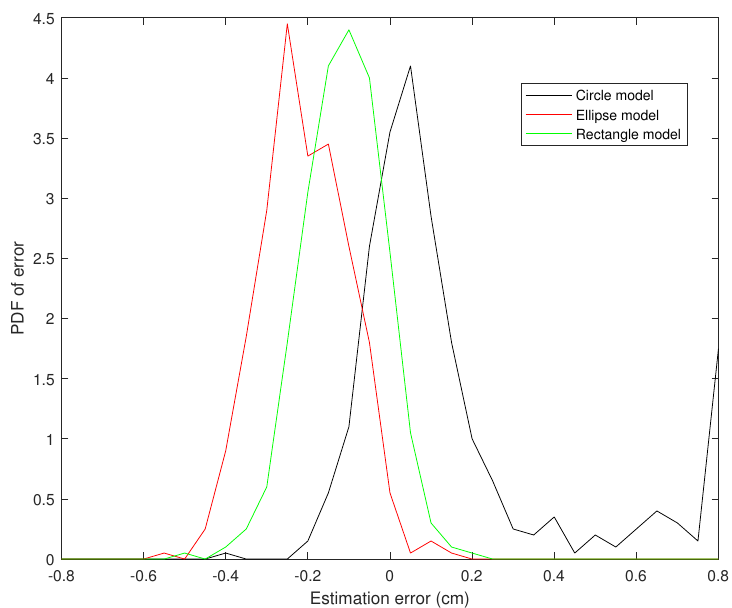
Figure 11. PDF of the AP-diameter estimation error w.r.t. manual measurement for the third sample video depicted in Figure 5, as measured by active circle algorithm (black line), active ellipse algorithm (red line) and active rectangle algorithm (green line).